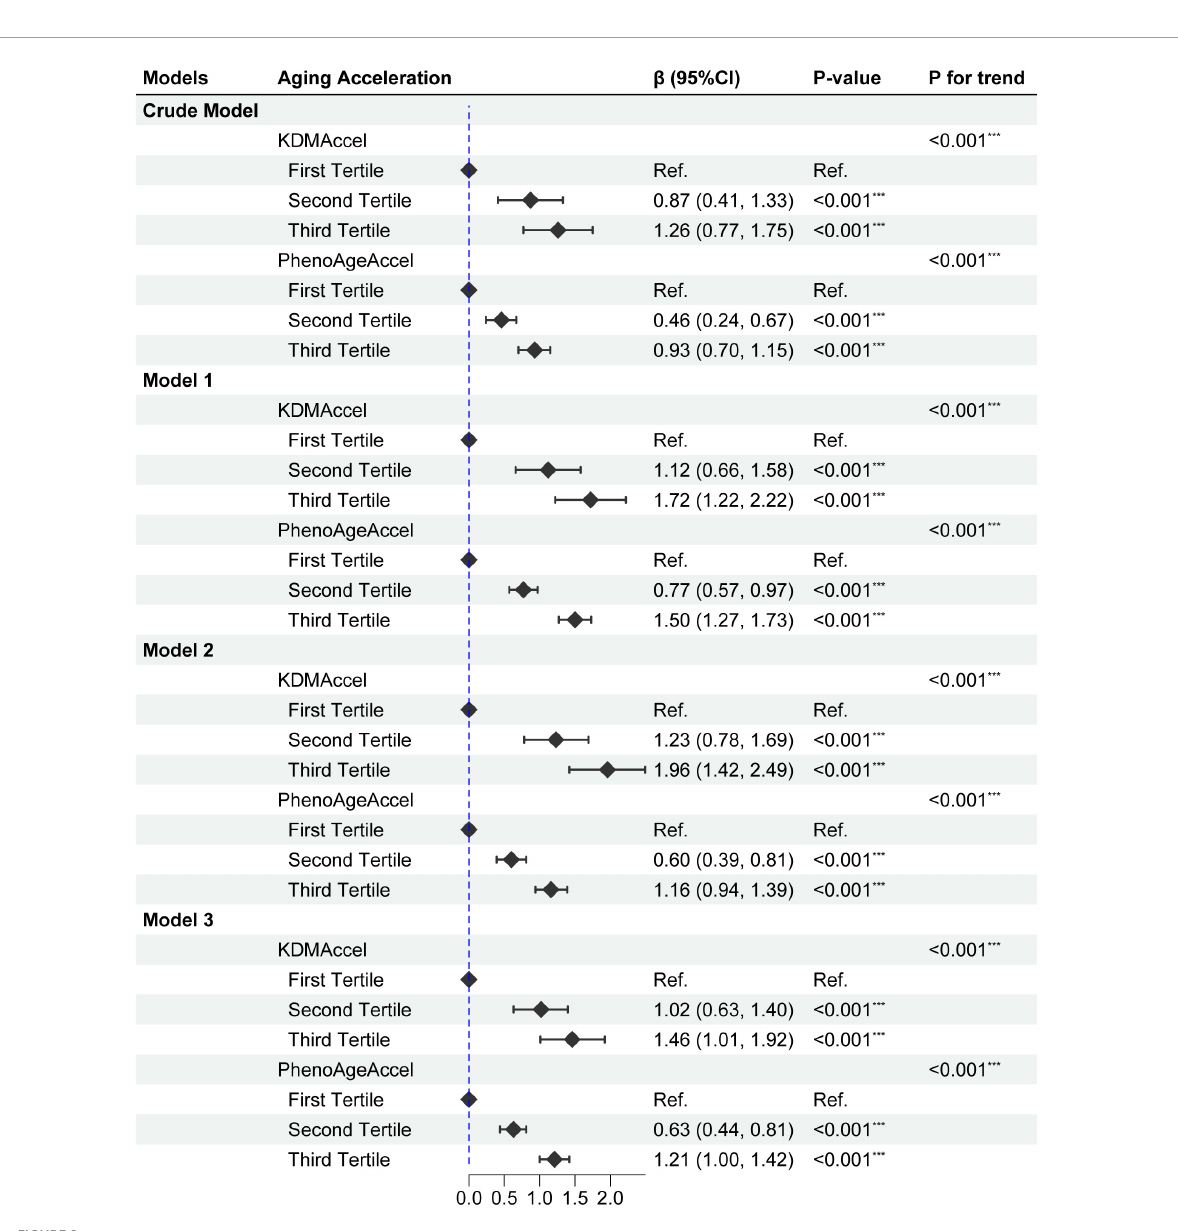
FIGURE2 Forest plot for the effect of dietary inflammatory index (DII) on aging acceleration. Model 1 adjusted for age, sex, ethnicity, and household income; Model 2 adjusted for sex, BMI, and total energy intake; Model 3 adjusted age, sex, ethnicity, household income, smoking status, BMI, total energy intake, CCI, CVD, hypertension, dysglycemia, MetS, hyperlipidemia, asthma, CKD, anti-hypertensive drug use, and anti-hyperlipidemic drug use. P -value: ***, <